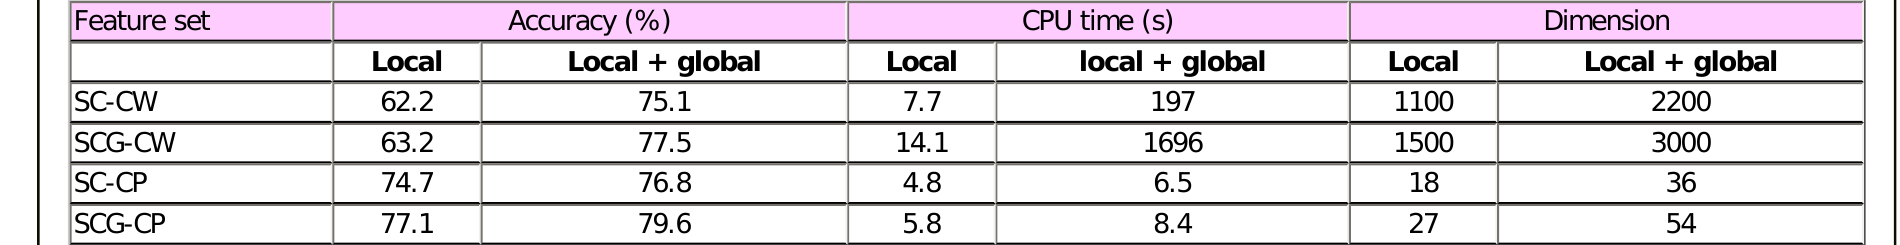
Table 8 Patch-level accuracies for the stage 1 LRC on MSRC-9 for various feature sets: SIFT (S), Color (C) and Gabor (G) descriptors represented by codewords (CW) or PLSA class probabilities (CP), using only local features, or local ones + global